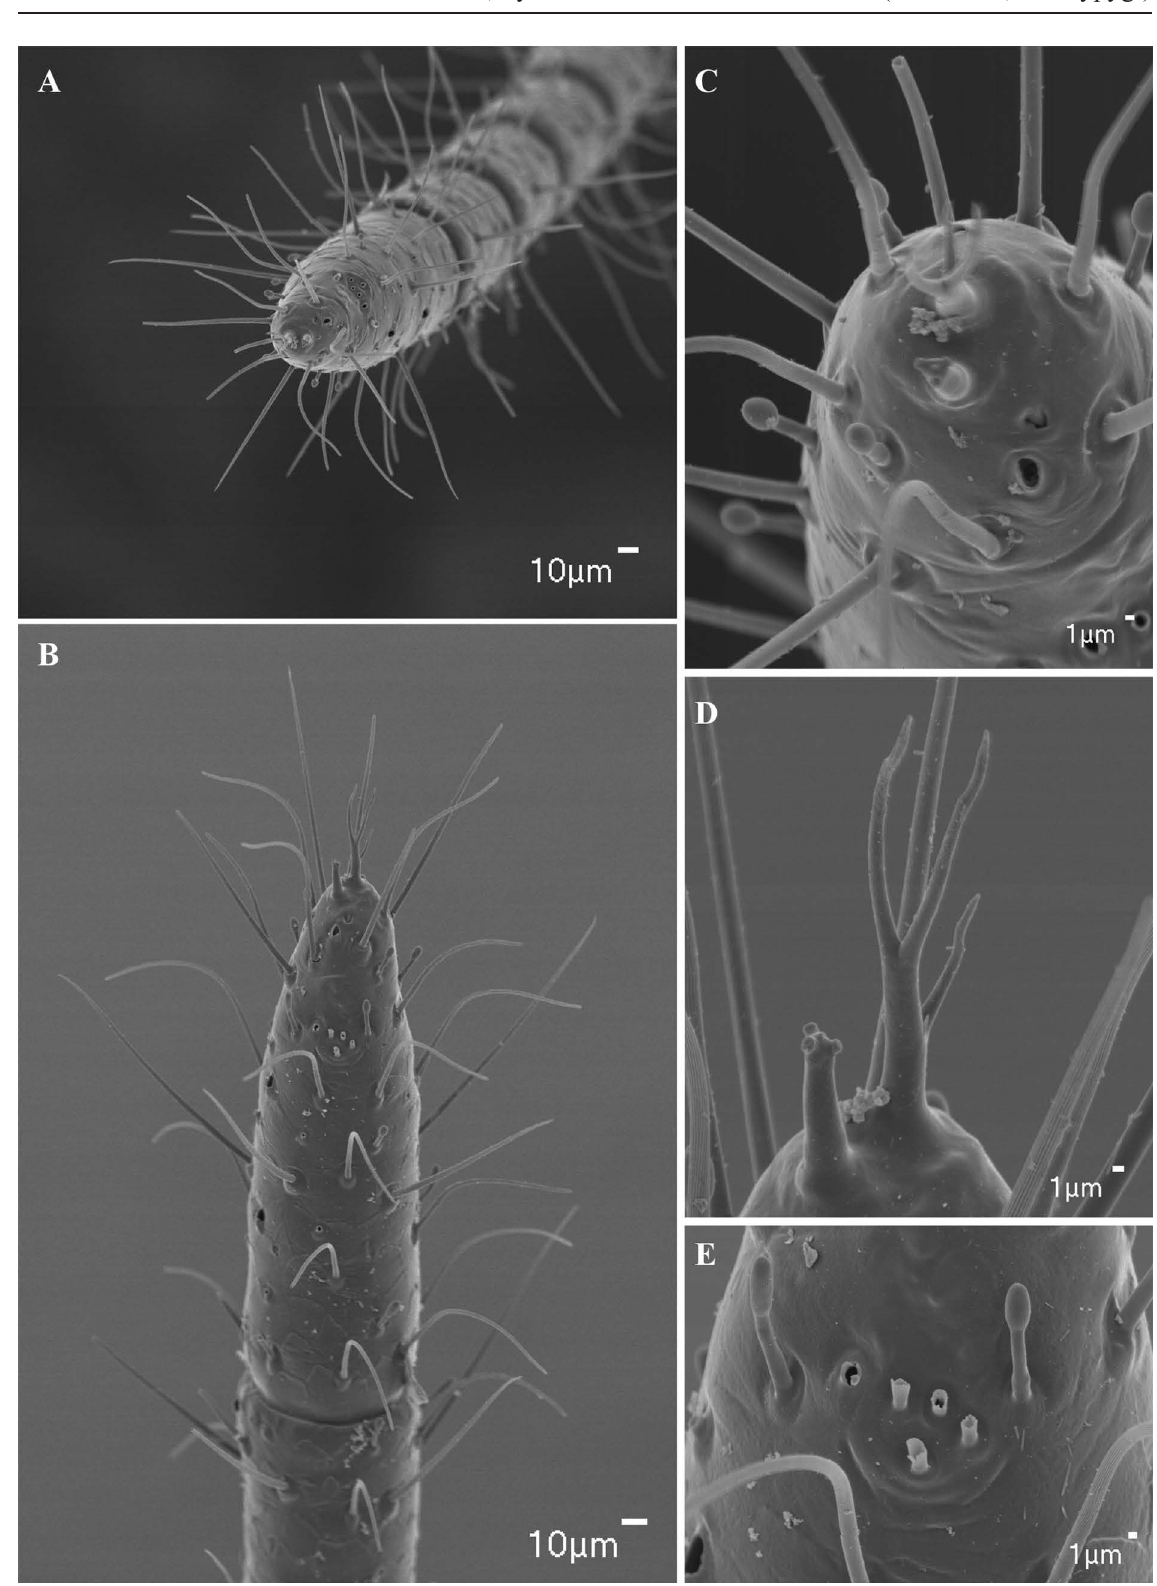
Fig. 19. Charinus caribensis (Quintero, 1986) (SMNS), antenniform leg I. A . Apex of distal article. B . Distal segment of tarsus, lateral view. C . Apex of distal article of tarsus showing claw and tarsal organ. D . Detail of claw tarsal organ. E . Rod sensilla and part of